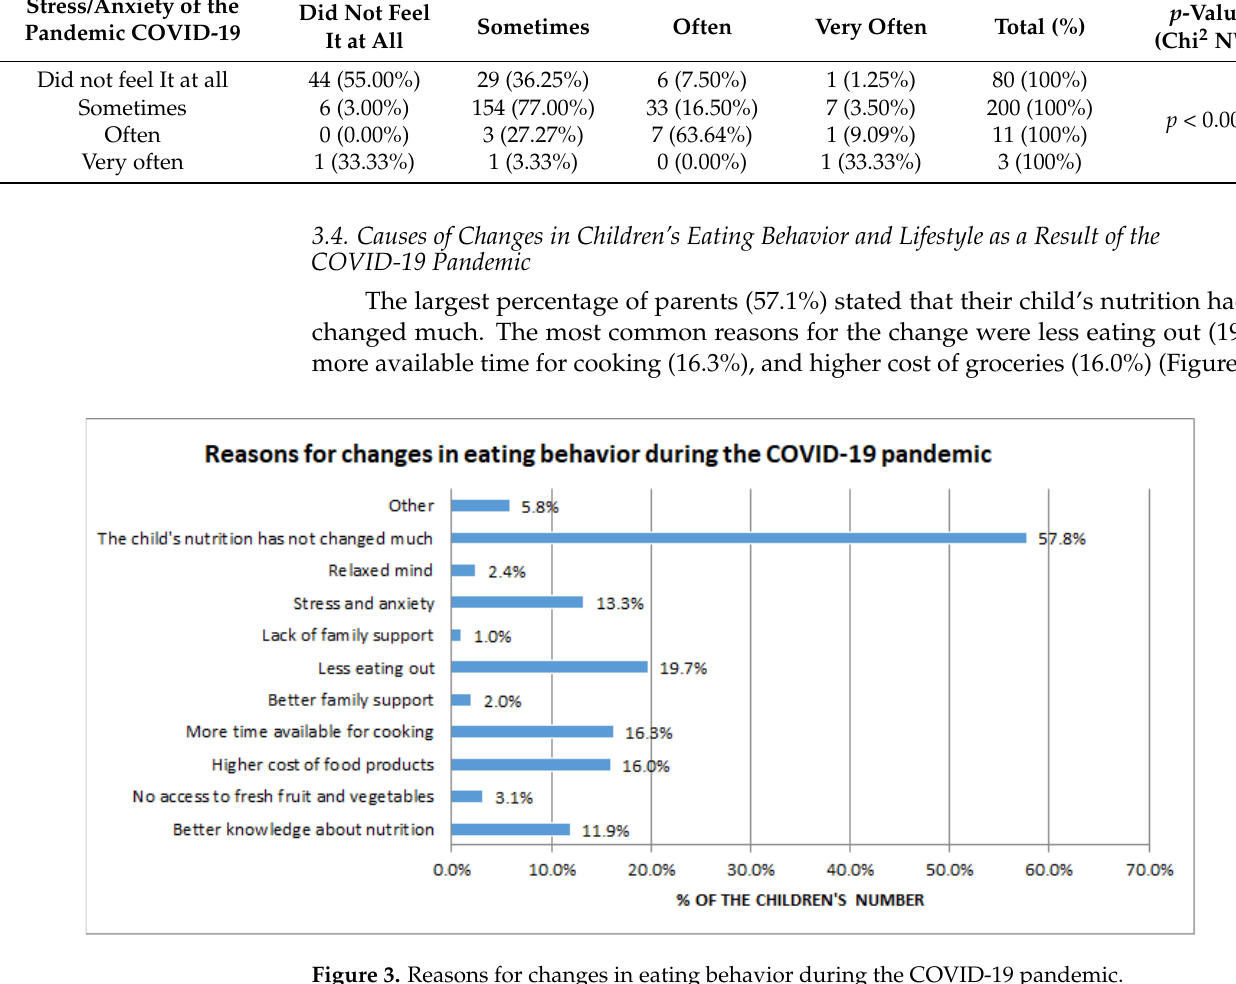
Figure 3. Reasons for changes in eating behavior during the COVID-19 pandemic. More than half of parents (53.7%) stated that their children’s physical activity had not changed. As reasons for the change, the largest percentage of parents indicated a lack